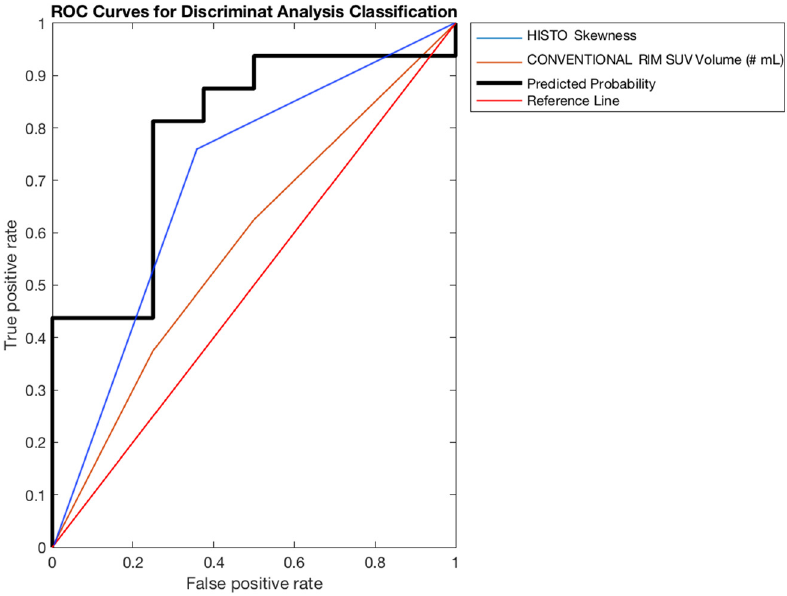
Figure 4. ROC curve for fixed ROI (SIEMENS patients’ group).